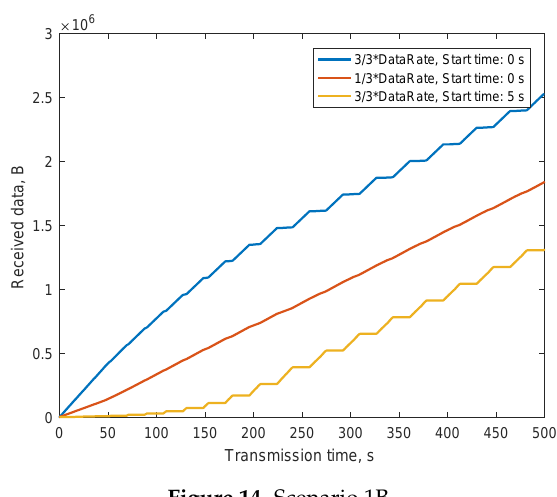
Figure 14. Scenario 1B.